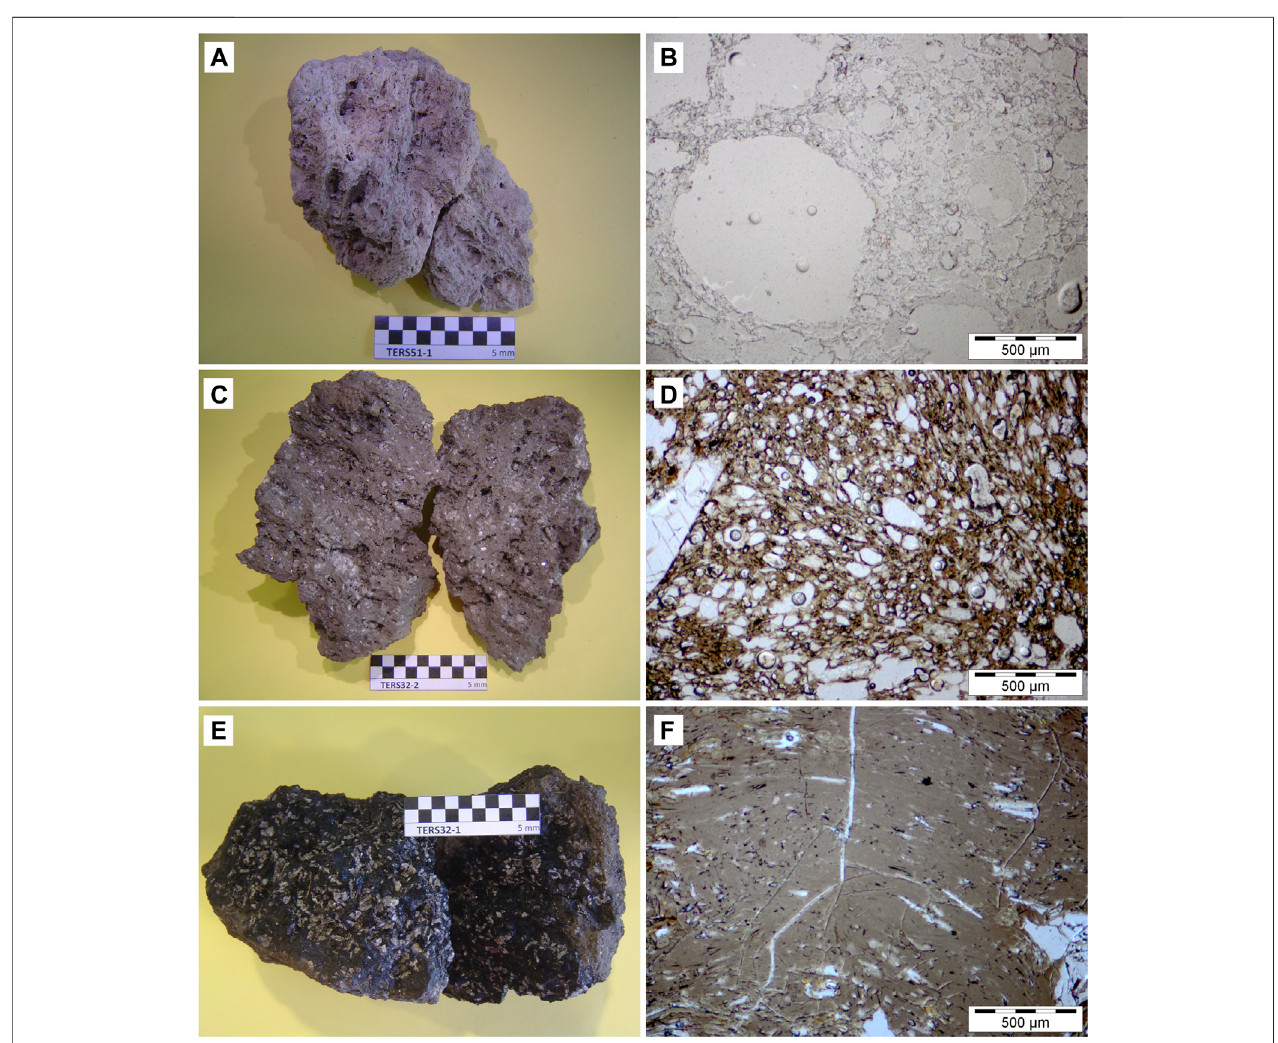
FIGURE 10 | Representative juvenile clasts of the LAI and photomicrographs showing their textures. (A) Light grey pumice clasts. (B) Highly vesicular pumice with millimetre-sized subcircular vesicles. (C) Dark grey coarsely porphyritic scoria clats. (D) Microvesicular scoria with subcircular to slightly elongated vesicles and an alkali feldspar phenocryst. (E) Black coarsely porphyritic dense clasts. (F) Dense clast with brown glassy groundmass, collapsed vesicles, and dispersed alkali feldspar